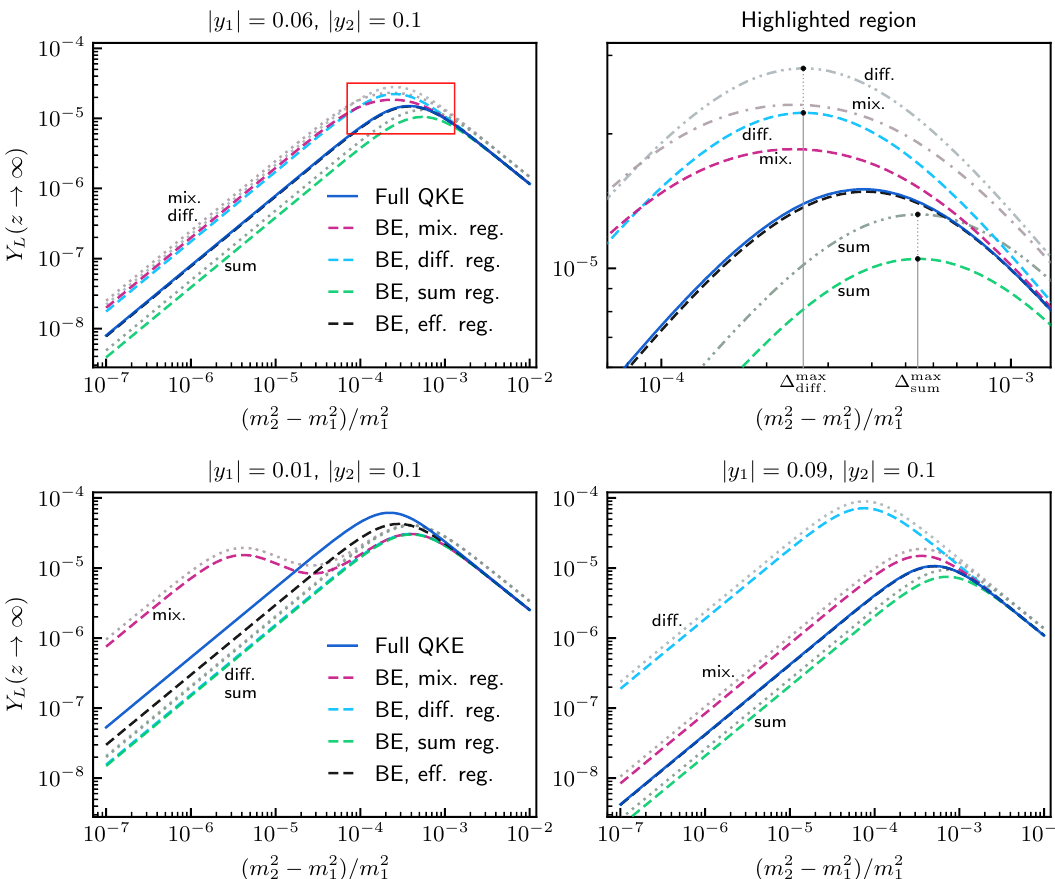
Figure 9. Shown is the asymptotic lepton asymmetry Y L as a function of the relative mass- squared difference ∆ m 2 /m 2 for different Yukawa couplings. The Boltzmann equation (BE) results 21 1 are shown with four different regulators for ε CP . The dotted and dash-dotted lines show the rate i equation results for the corresponding BE results. The top-right panel shows the region highlighted in red in the left. The bottom panels have hierarchical (left) and almost degenerate (right) Yukawa couplings. Other parameters have the benchmark values and vacuum initial conditions were